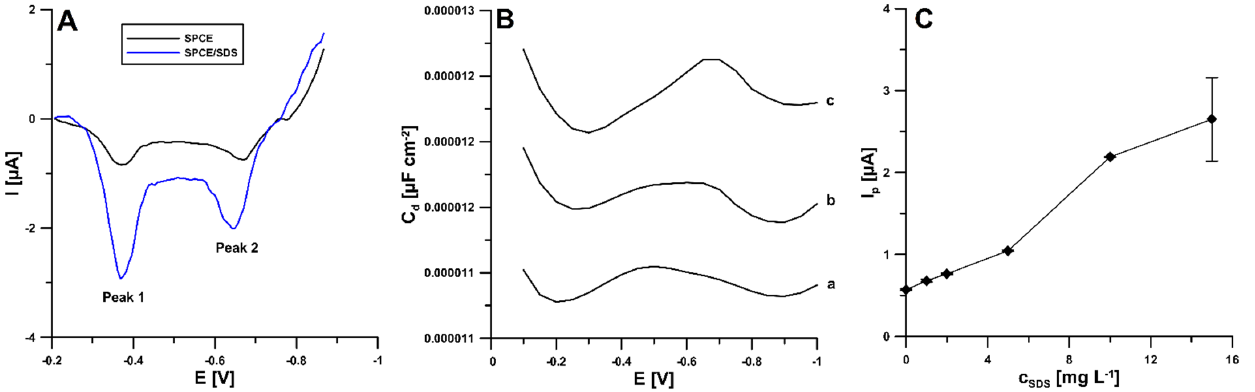
Figure 3. ( A ) Voltammograms of 50 nM NDIT obtained at the SPCE and SPCE/SDS (in the presence of 10 mg/L SDS). ( B ) The differential capacity–potential curves of the double ‐ layer interface SPCE/supporting electrolyte in the presence of 0 (a), 10 (b), and 20 (c) mg L − 1 SDS. ( C ) The rela ‐ tionship between the 50 nM NDIT peak current and SDS concentration from 0 to 15 mg/L.